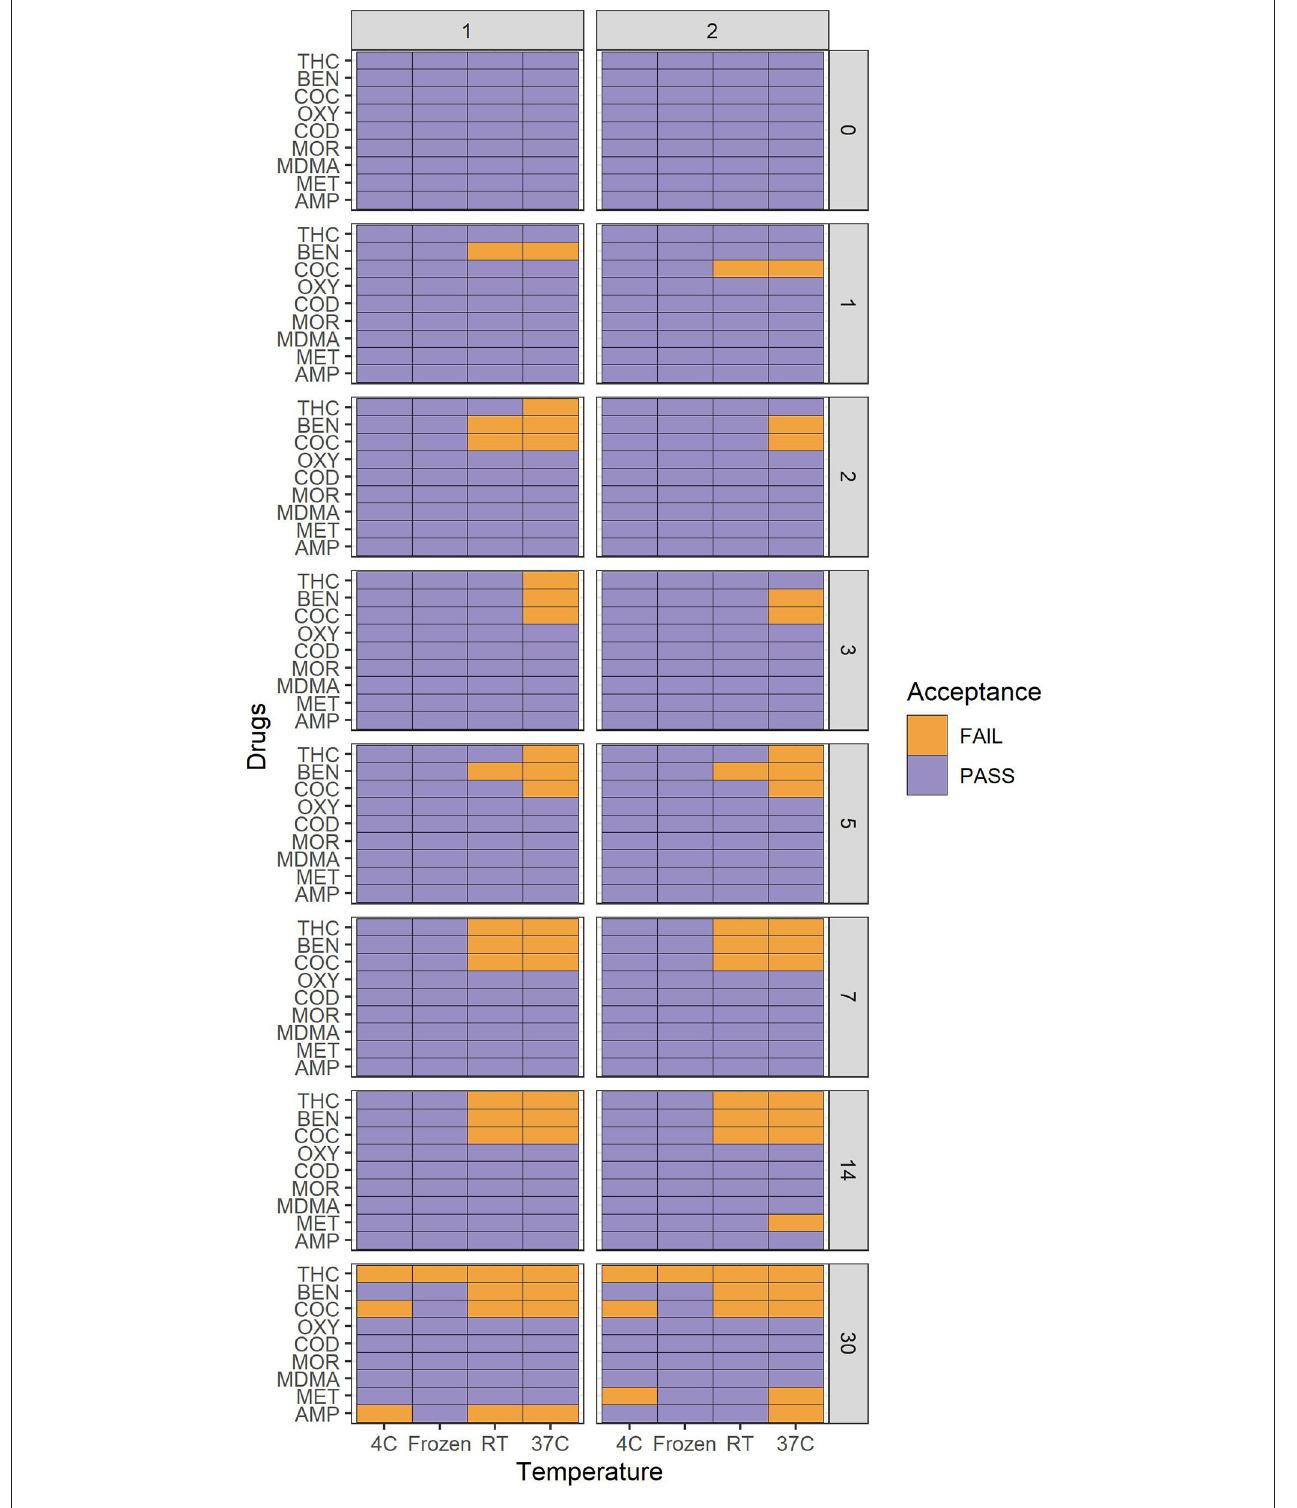
FIGURE 1 | Heatmap of drug stability within ± 20% acceptance range over a period of 30 days. Within ± 20% = "Pass" or "Fail". The y-axis represents drugs tested, and x-axis represents storage temperature. Vertical facet 1 = − 50% and facet 2 = + 50% cut-off. Horizontal facets represents days from 0 to 30.